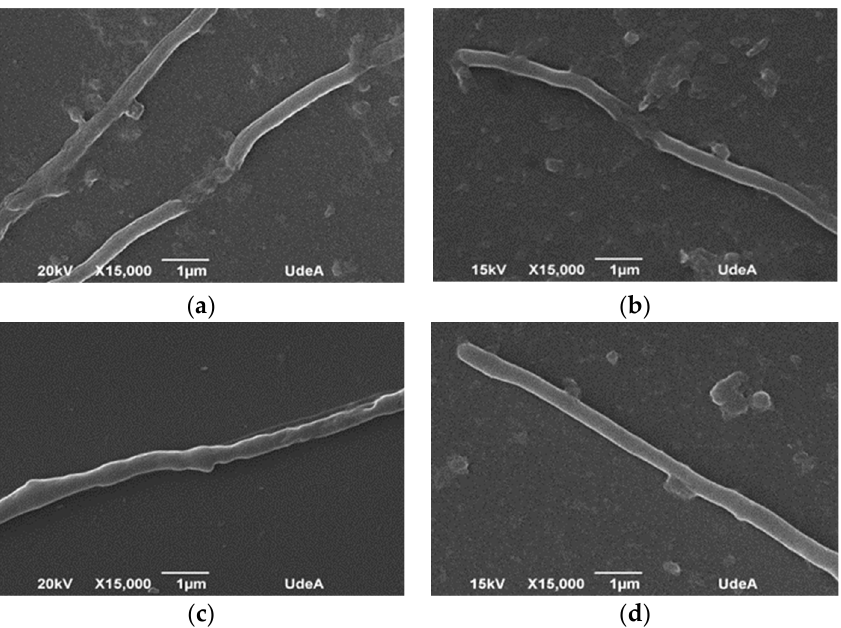
Figure 6. Scanning electron microscopy of Streptomyces clavuligerus at 72 h culture in: ( a ) baffled flask, ( b ) flask with helical spring on the bottom, ( c ) flasks with submerged glass beads, and ( d ) smooth flask.